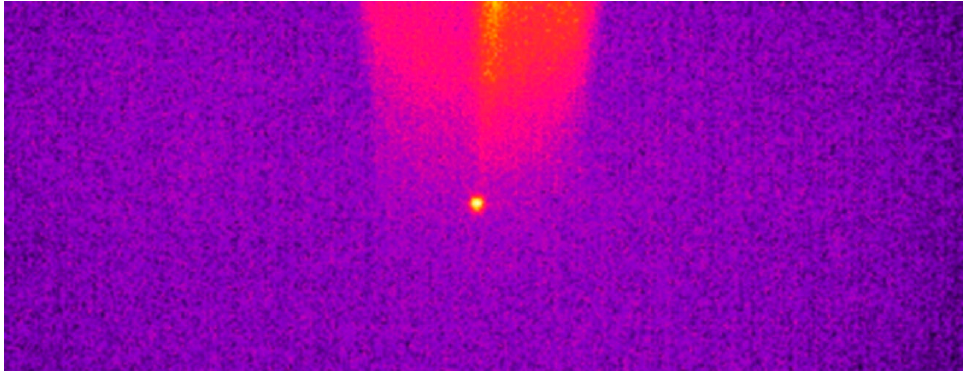
t = 0.258 s, Δ T = 2.6 ℃ (experiments)